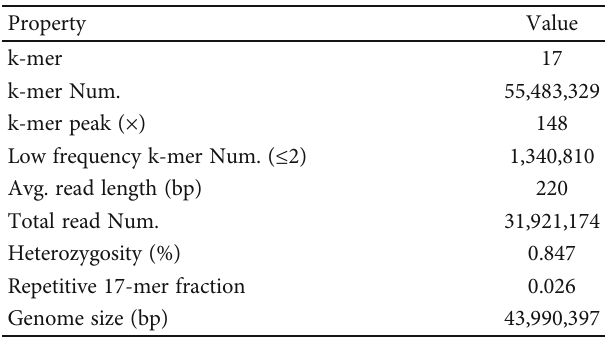
Table 3: Result of 17-mer